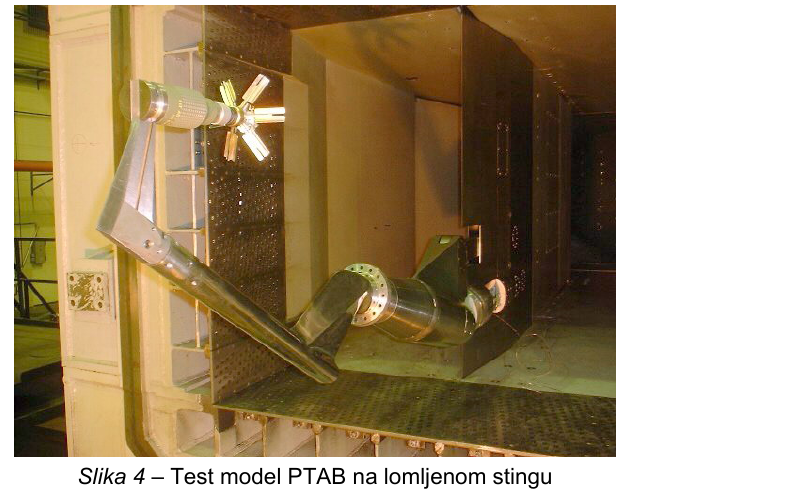
Рис . 4 – Тестовая модель ПТАБ на кривой державке Figure 4 – PTAB test model on a broken